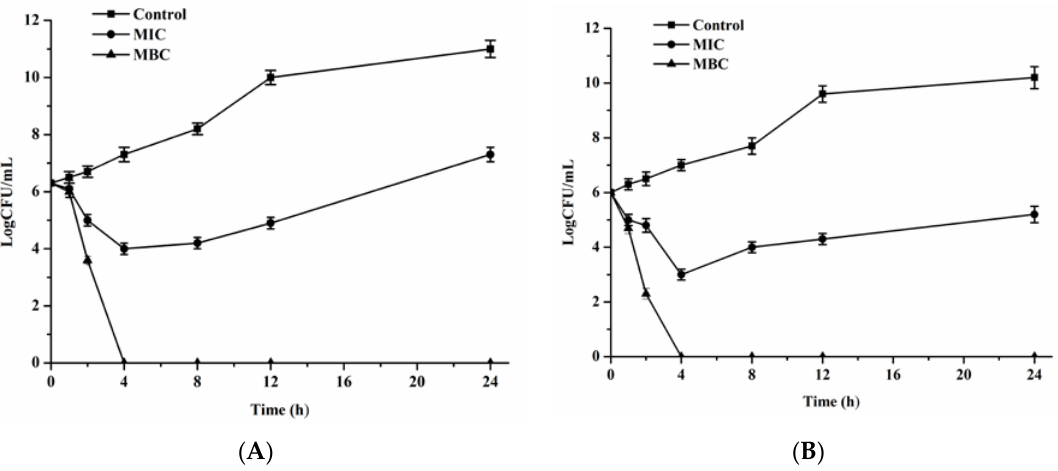
Figure 1. Time-kill kinetics of FEO against E. coli ( A ) and S. aureus ( B ). The concentrations used correspond to control, MIC, and MBC.